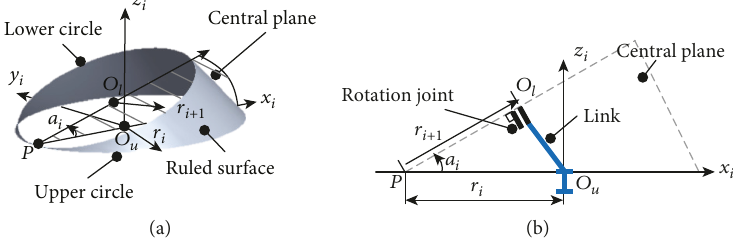
Figure 3: Geometric structure and parameters of (a) joint part and (b) link.